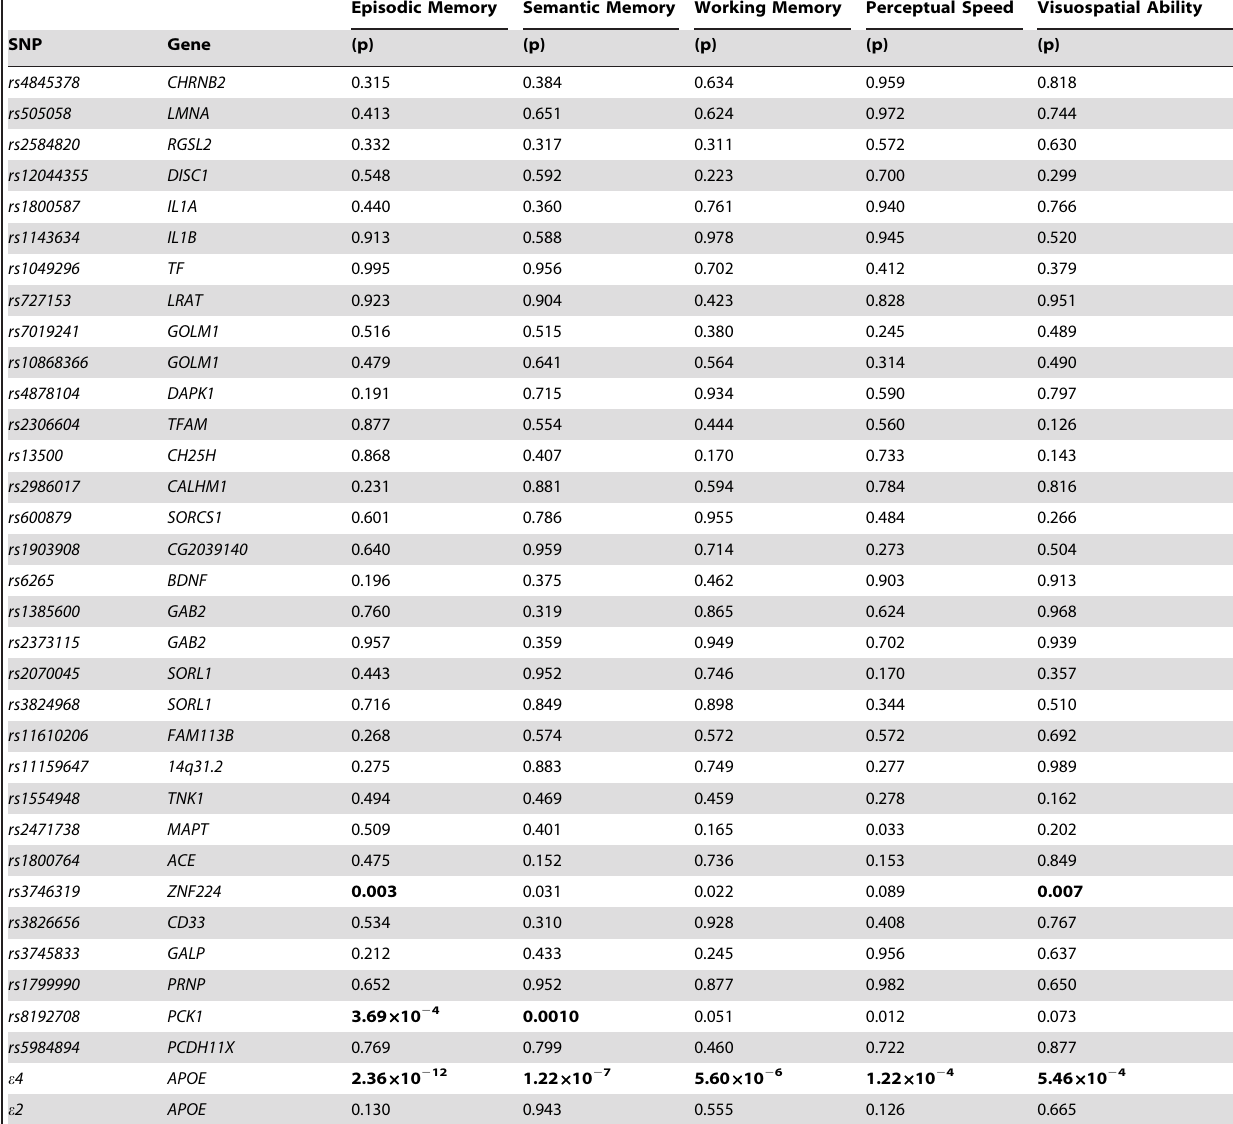
Table 5. Relation of polymorphisms to measures of cognitive